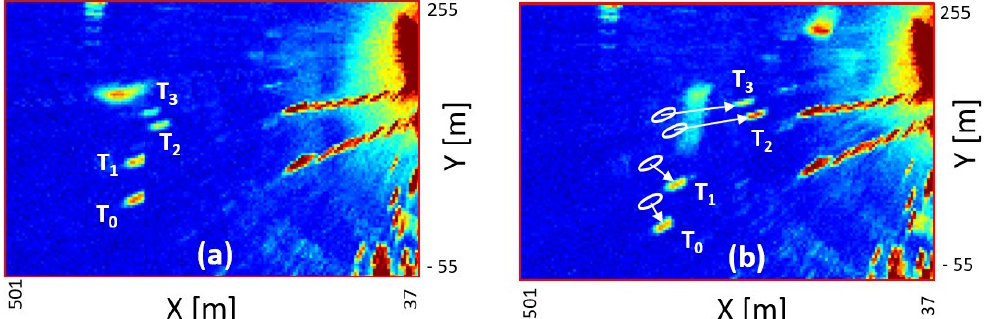
Figure 14. Movements of the targets within the survey area related to the second release. ( a ) Begin- ning of the second release of the target; ( b ) before recovery of the target.